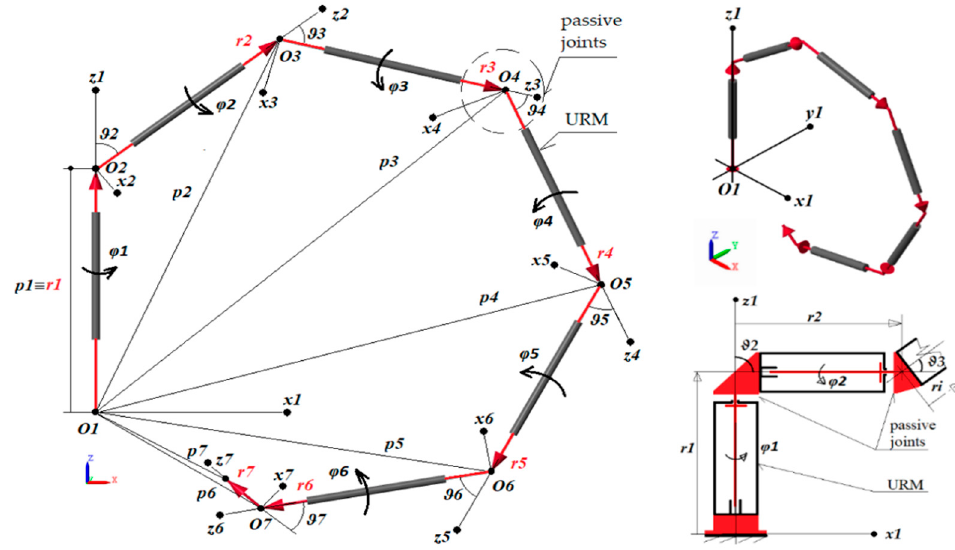
Figure 1. Robotic arm vector model composed of the universal rotational modules (URM) mod-